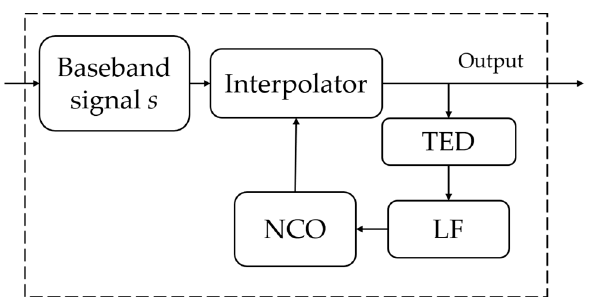
Figure 1. The structure of Gardner algorithm.